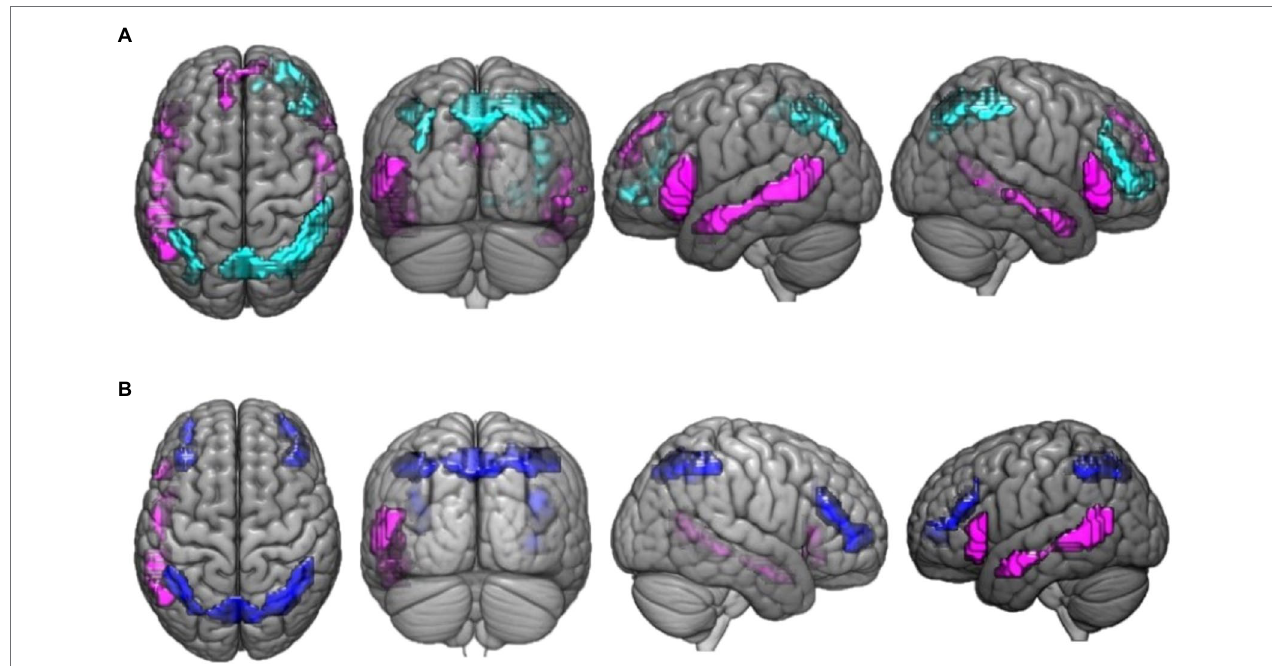
FIGURE 2 | This figure presents the neuroimaging results of the comparison between deductive reasoning and paradoxical reasoning trials: (A) activation maps of areas that were differentially activated between deductive reasoning for valid syllogisms and paradoxical reasoning trials. Cyan color marks the areas that were more active for deductive valid reasoning compared to paradoxical reasoning while violet marks the areas that were more active for paradoxical reasoning compared to deductive valid reasoning. (B) Activation maps of areas that were differentially activated between deductive reasoning for invalid syllogisms and paradoxical reasoning trials. Blue color marks the areas that were more active for deductive invalid reasoning compared to paradoxical reasoning while violet marks the areas that were more active for paradoxical reasoning compared to deductive invalid